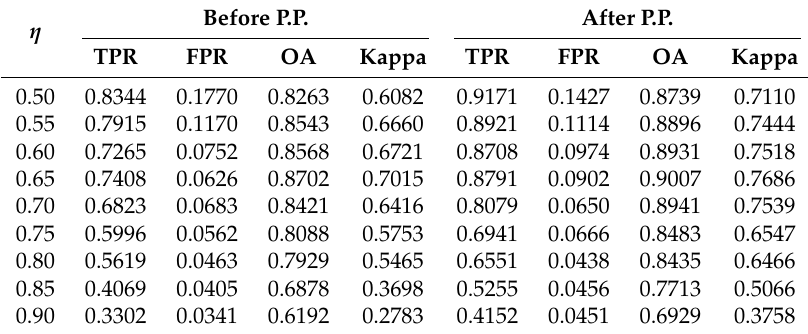
Table 5. Performances of the proposed method before and after post-processing for different η when n = 21 using the DigitalGlobe